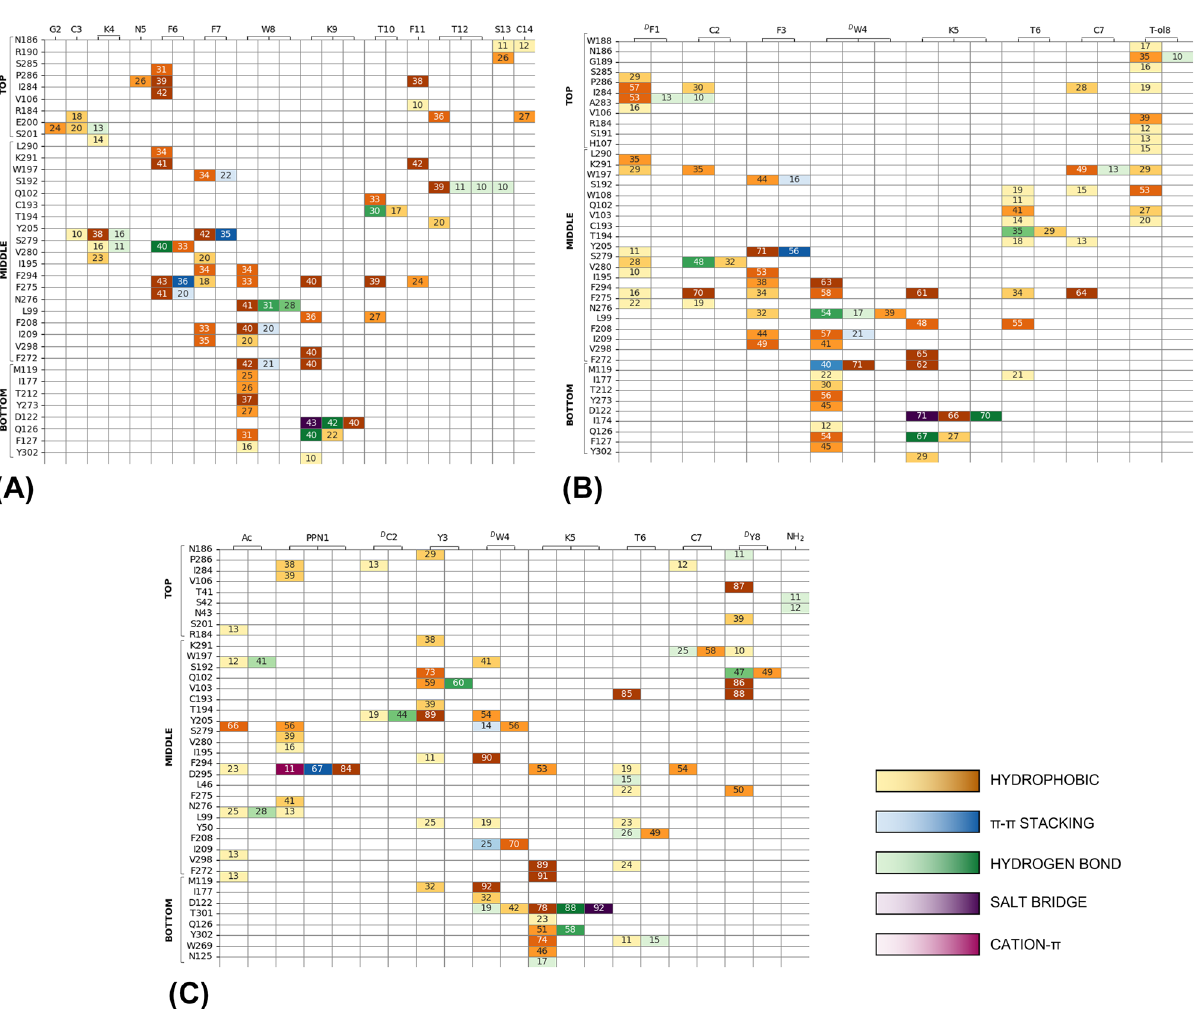
Figure 6. Interaction fingerprints for ( A ) SSTR2-SST14, ( B ) SSTR2-OCT, ( C ) SSTR2-CYN. The numbers indicate the persistence of interaction (%) between the residue of SSTR2 (vertical axis) and that of the ligand (horizontal axis). Darker colors correspond to higher persistences. Interactions are coloured according to their type: yellow to orange for hydrophobic, blue for π - π stacking, green for hydrogen bonds, violet for salt bridges, and magenta for cation- π . Only interactions equal or greater than 10% are reported. The residues of SSTR2 are divided according to the pocket regions (i.e., top, middle, bottom) and ordered according to their spatial